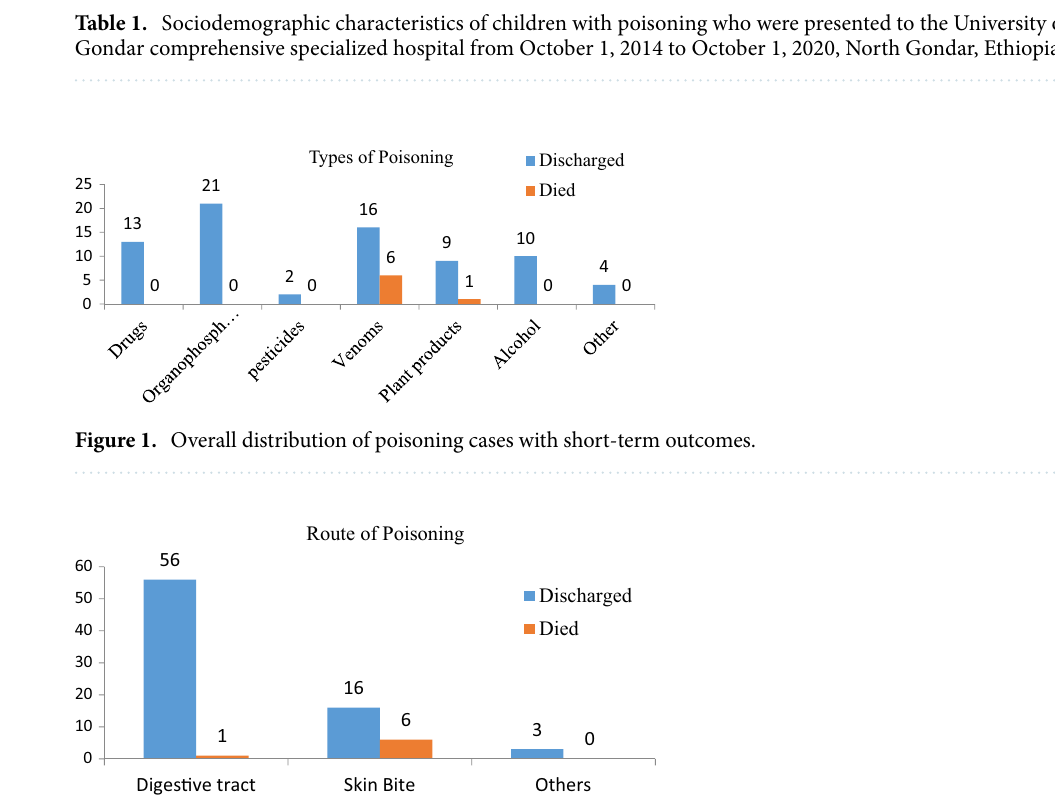
Figure 2. Overall distributions of poisoning cases by rout of ingestion with short-term